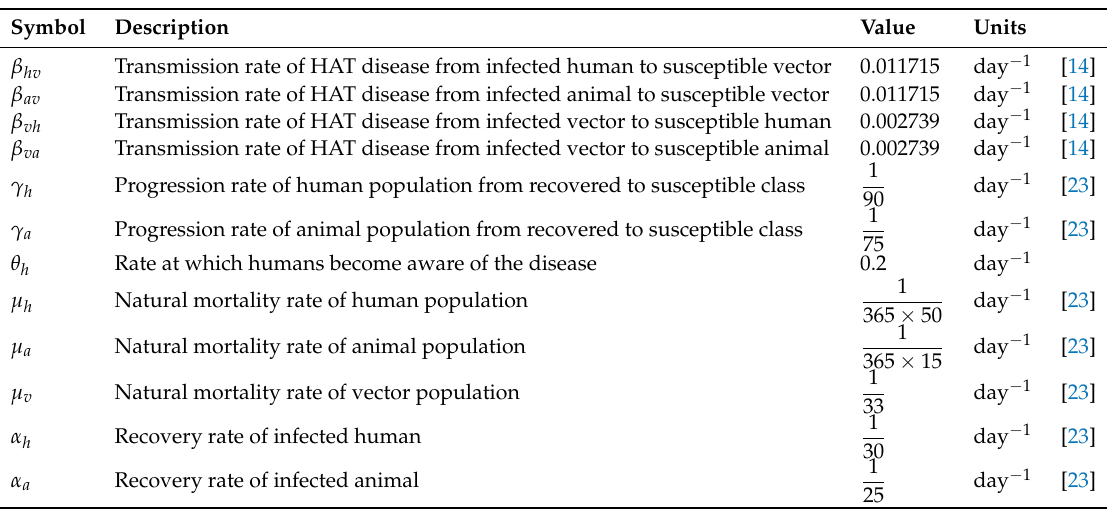
Table 1. Description of parameters used in system (1). HAT: human African trypanosomiasis. Symbol Transmission rate of HAT disease from infected human to susceptible vector Transmission rate of HAT disease from infected animal to susceptible vector β